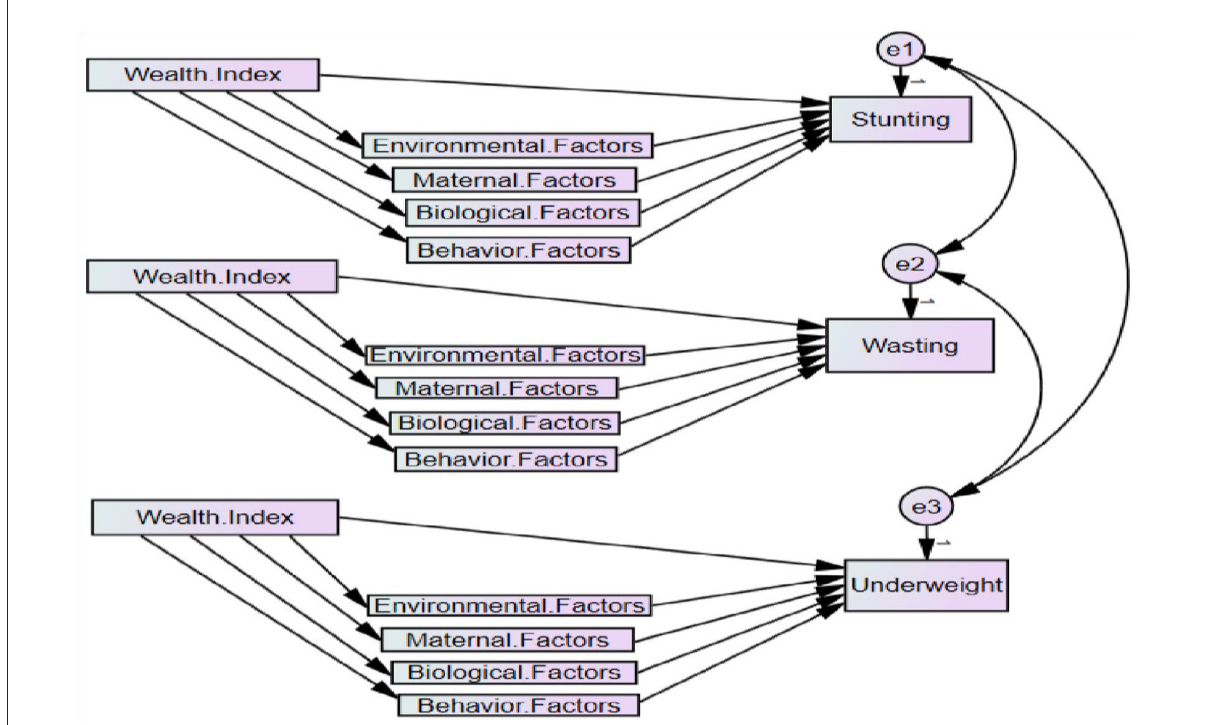
FIGURE1 Hypothetical framework of mediators of the link between wealth index and anthropometric indices stunting, underweight, and wasting.